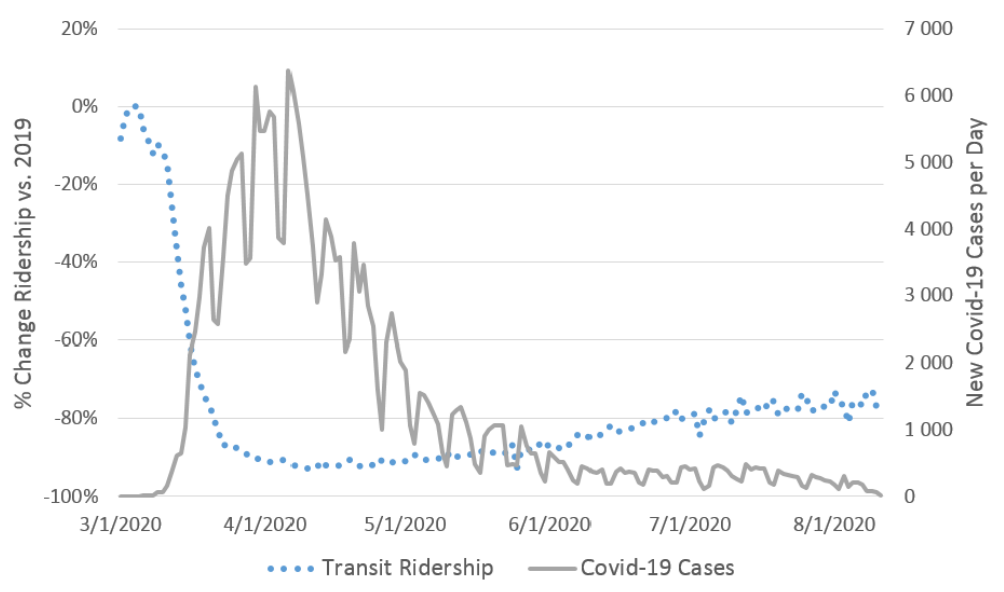
Figure 3. Percent change in ridership on the New York City subway system compared with 2019 versus daily new COVID-19 cases from 1 March to 11 August 2020. Data source: New York Metropolitan Transit Authority (MTA).